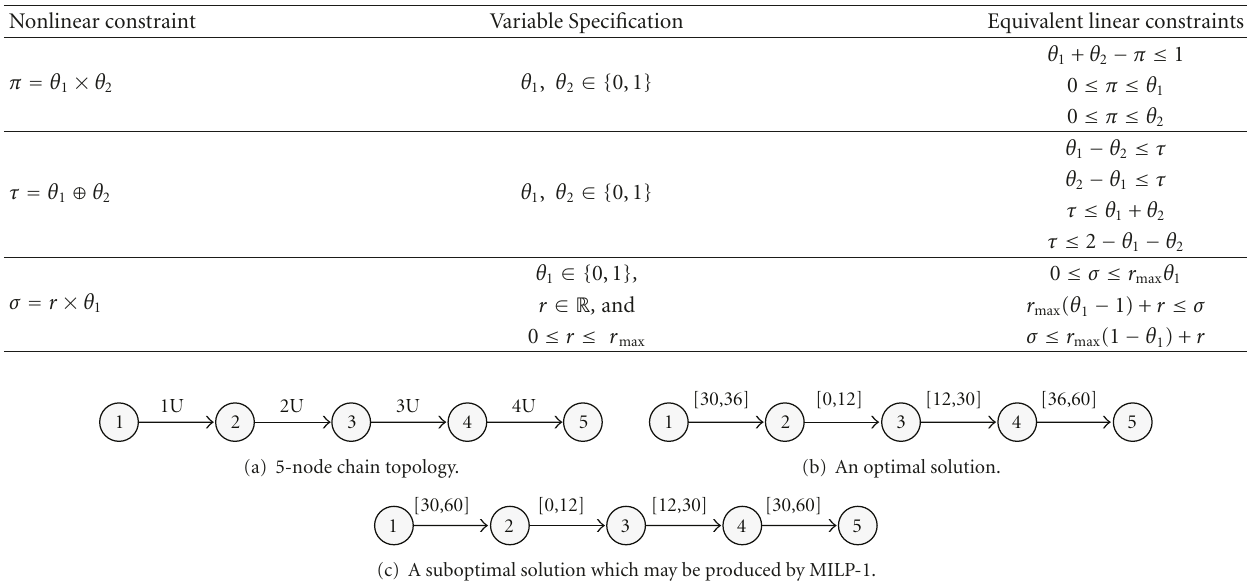
Table 1: Binary linearization techniques.